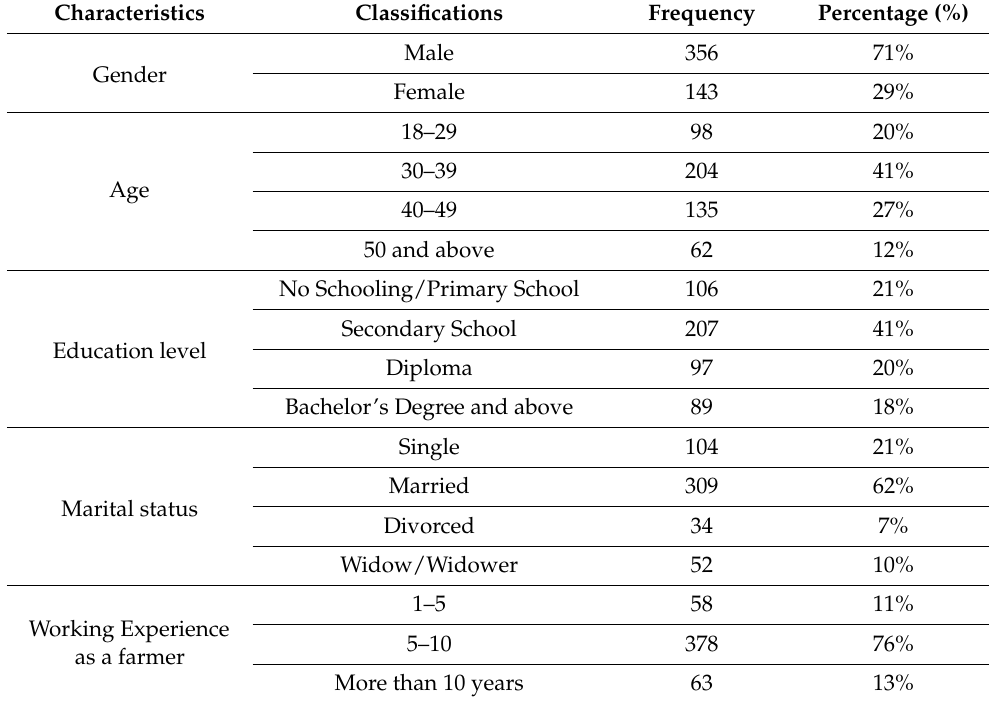
Table 3. Demographic characteristics of the respondents.